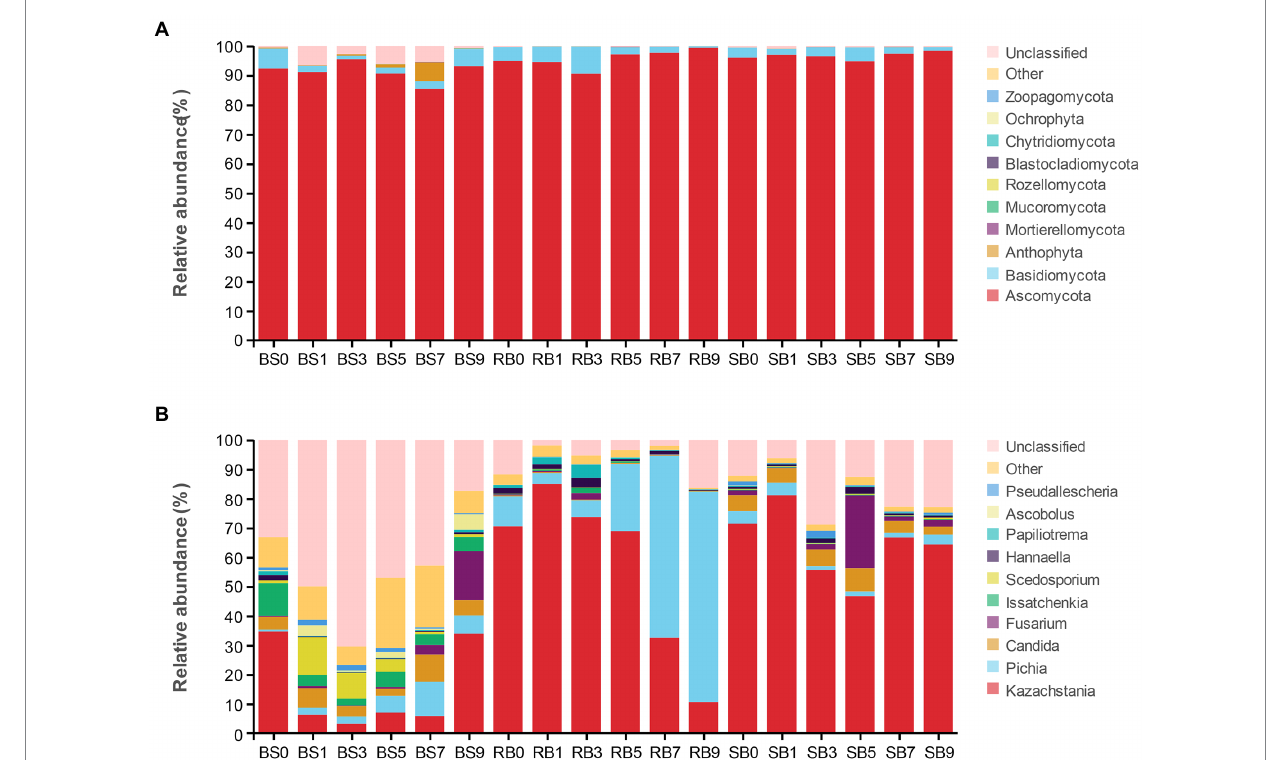
FIGURE 4 The dynamic fungal community of the WPCS during aerobic exposure. The fungal communities were shown at the phylum level (A) and the genus level (B) . BS, Bunker silo; RB, Round bale; SB, silage bag. 0, 1, 3, 5, 7, 9: 0, 1, 3, 5, 7, 9 days of aerobic exposure,